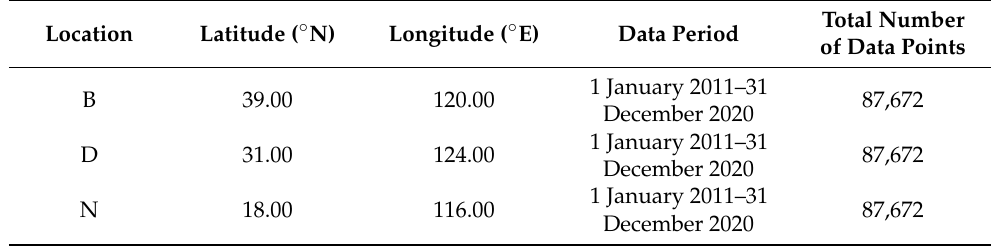
Figure 1. The specific location. Table 1. Specific information about the selected location.